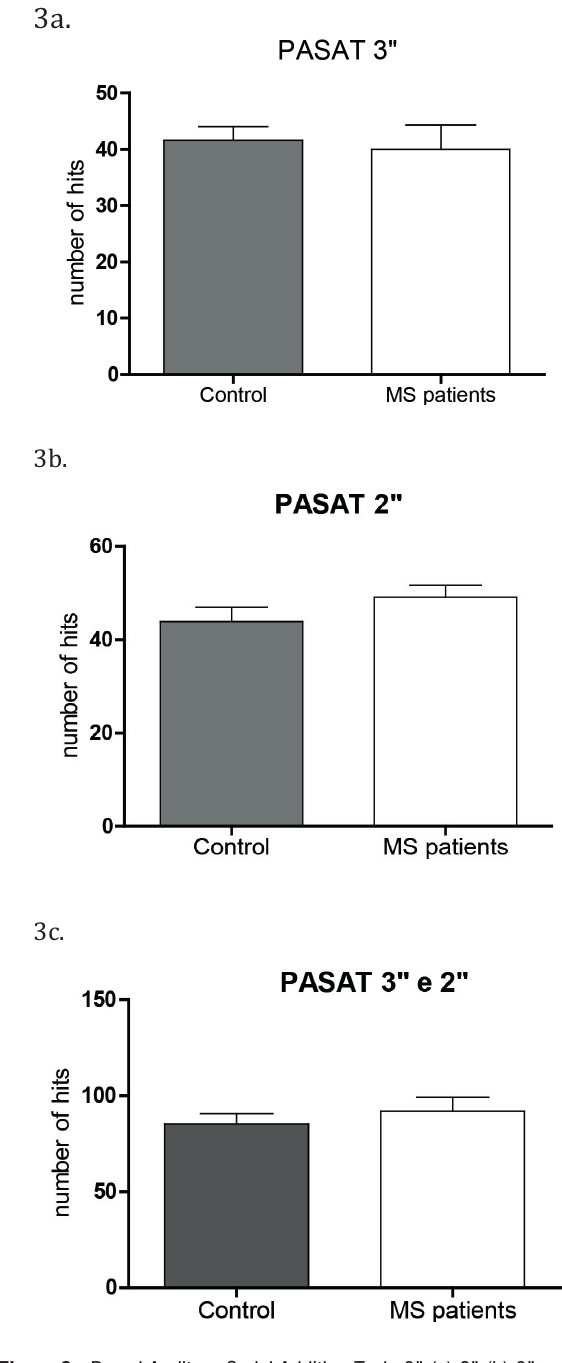
Figure 3 - Paced Auditory Serial Addition Task: 3” (a) 2” (b) 3” and 2” (c) for the MS and control groups. Values represented as mean ± SD. (Student’s t-test, p < .05 n = 10 and n = 7, respectively).